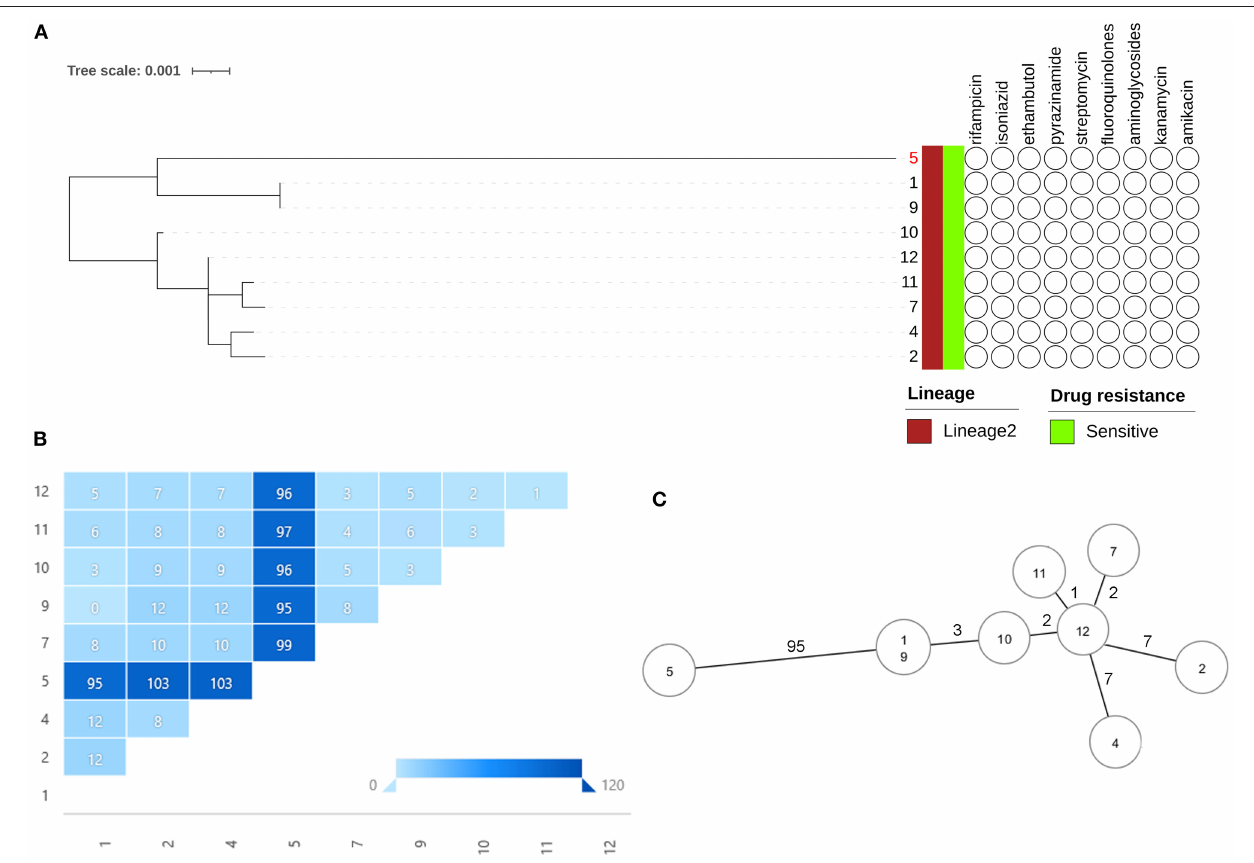
FIGURE 2 | Outbreak defined by WGS. (A) The phylogenetic tree combination with lineage and genotypic drug resistance of Mtb isolates (index case 5 showed in red). (B) SNP distances between each two Mtb isolates. (C) MST based on the SNP